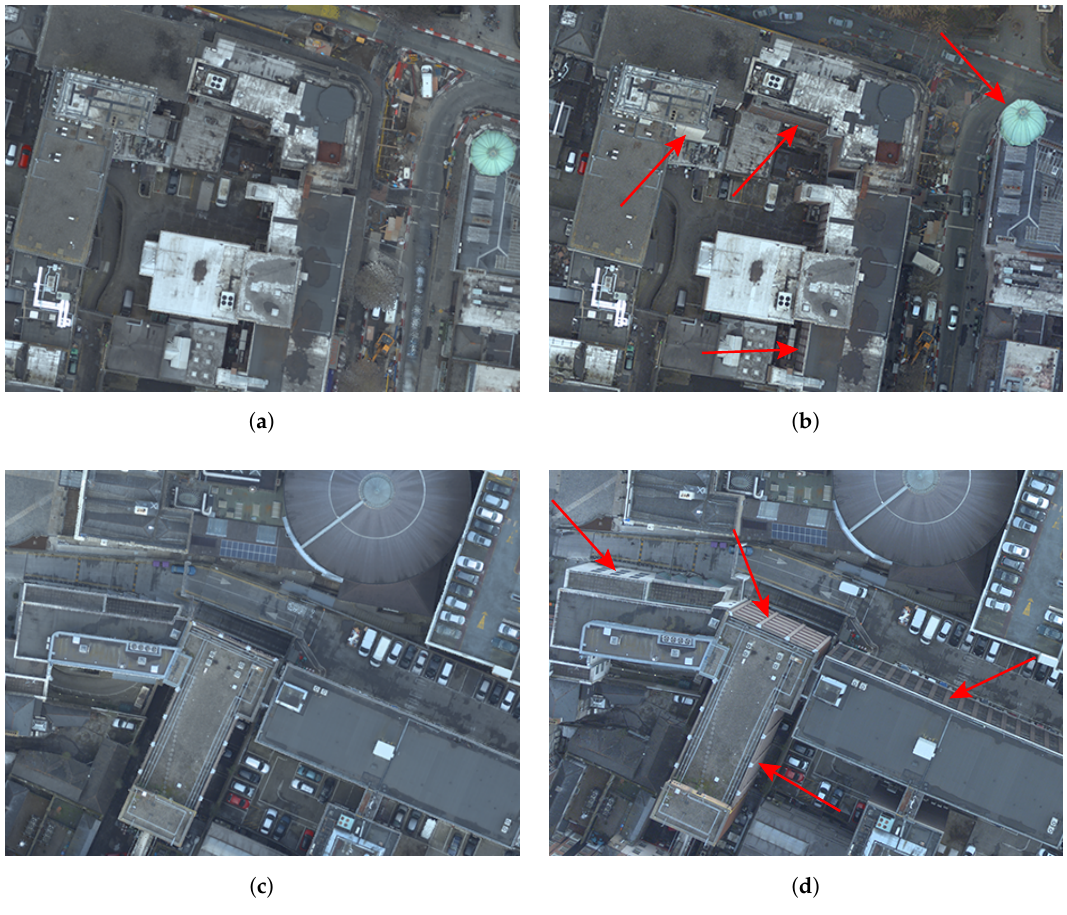
Figure 22. ( a ) Part of the true orthophoto for the Trinity College study area, and ( b ) digital terrain model (DTM)-based orthophoto for the same area; ( c ) A portion of the true orthophoto for the Dawson Street study area, and ( d ) the corresponding DTM-based orthophoto. Pixel size is 10 cm in the